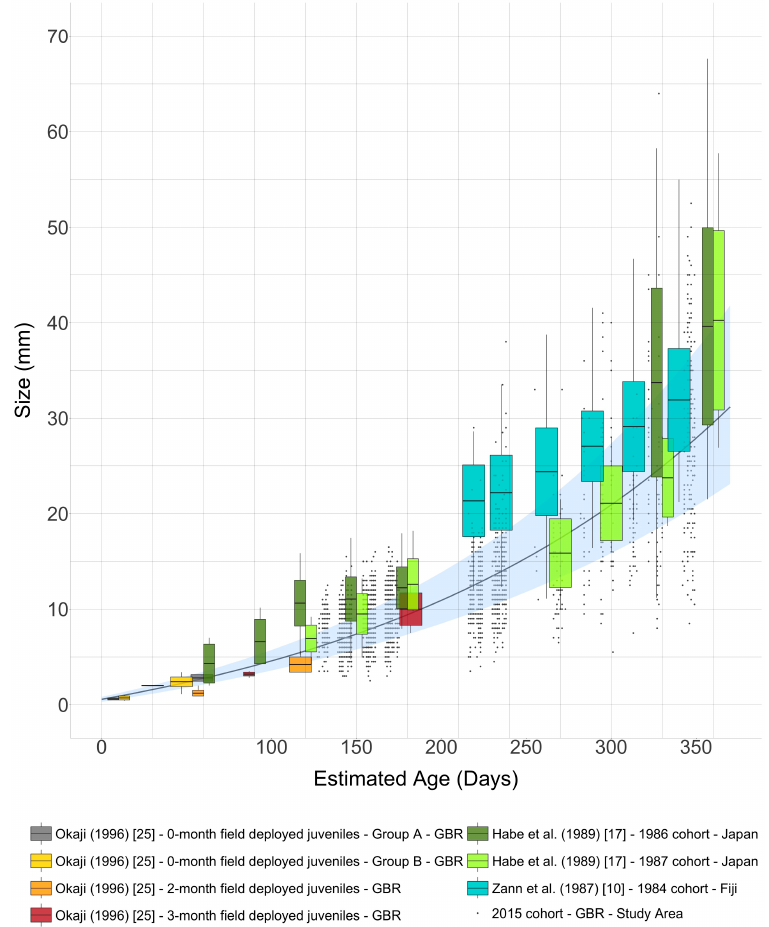
Figure 3. Fitted growth curve (black line) and combined 95% confidence interval for the 2015 crown-of-thorns starfish cohort (GBR). Individual observations of the 2015 cohort are depicted as points, while boxplots represent the results of previous field studies (Zann et al., 1987 [10], n = 651; Habe et al., 1989 [17], n 1986 = 683 and n 1987 = 125; Okaji, 1996 [25], n initial = 1137 and n final = 138). Each boxplot is characterised by a mean size (horizontal middle line), ± one standard deviation (rectangle), and minimum and maximum size (vertical line). Note that the estimated age in Zann et al. (1987) [10] and Habe et al. (1989) [17] likely represents the age after fertilisation without taking into account potentially long planktonic larval durations (PLDs); ages are therefore likely to be underestimated. In contrast, the estimated age in Okaji (1996) [25] and the present study represents the age after metamorphosis (i.e., after settlement).